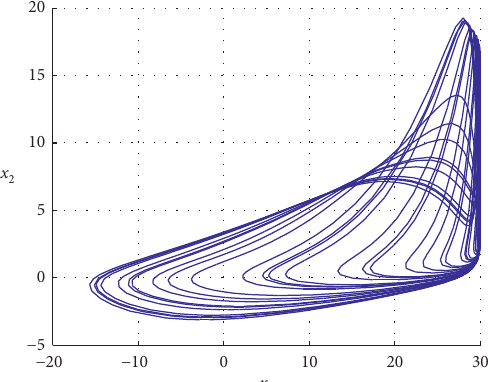
Figure 3: Two-dimensional projection of the chaotic neural net- work system on x 1 x 3 -coordinate plane.